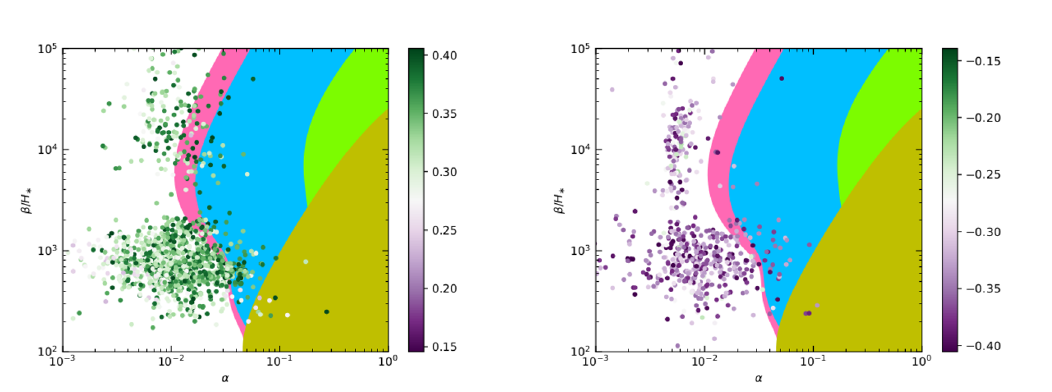
Figure 12 . The pink, blue, yellow, and green regions represent respectively the sensitivities of BBO, DECIGO, LISA, and B-DECIGO exceeding the detection threshold, assuming the nucleation temperature T n = 200 GeV. The scatter points are the samples that both generate a strong (cid:12)rst- order EWPT and survive the collider searches and DM experiments. The colored bar shows the values of (cid:18) . The samples with (cid:18) > 0 are plotted in the left plot, while the samples with (cid:18) < 0 are plotted in the right plot.